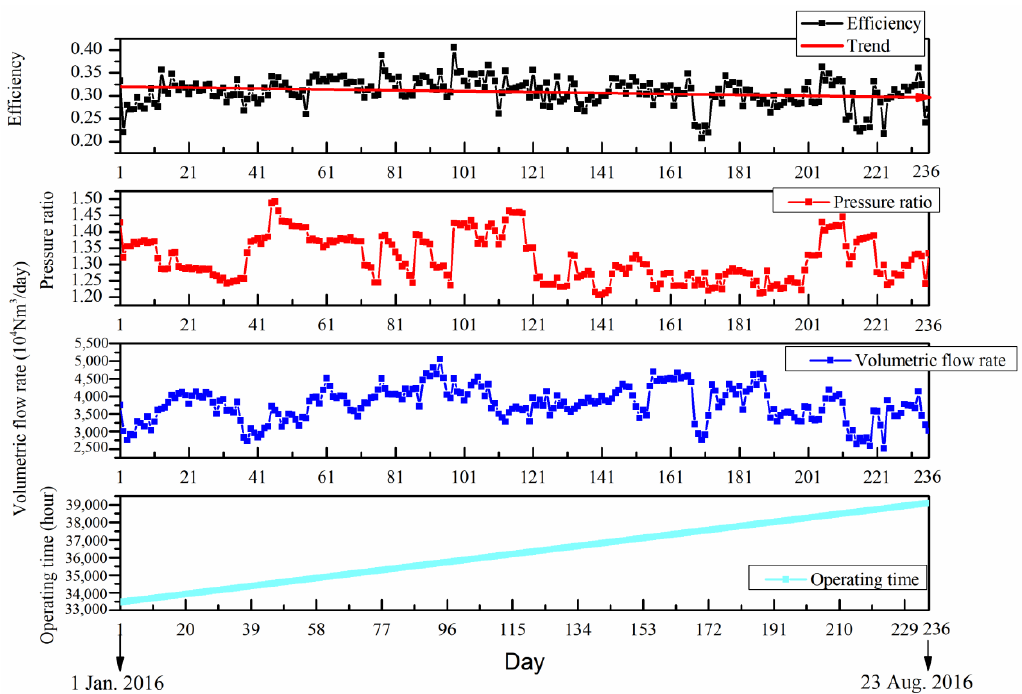
Figure 3. The performance parameters and operating time for the 2# compressor unit from 1 January to 23 August in 2016.